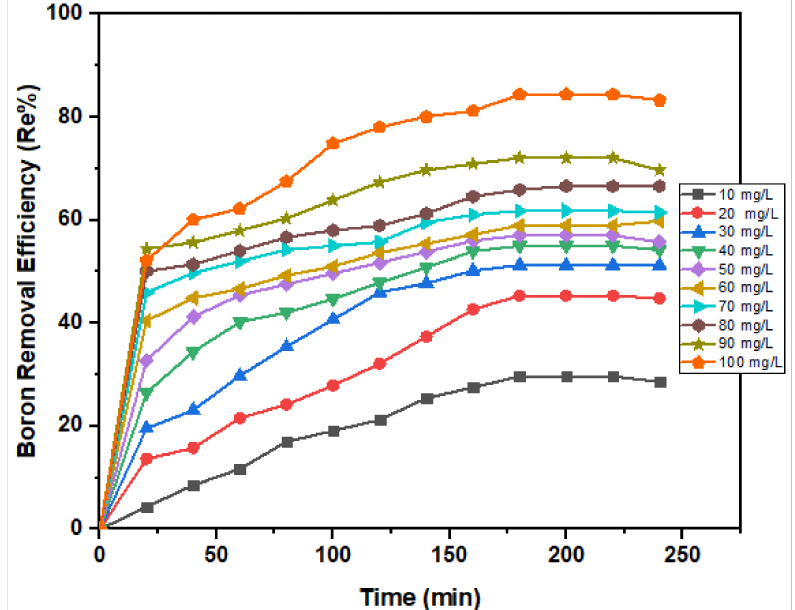
Figure 9. Boron removal efficiency by nano-magnetite under variable initial concentrations (10–100 mg/L) at constant pH (8), dosage (0.5 g), and variable contact times (20–240